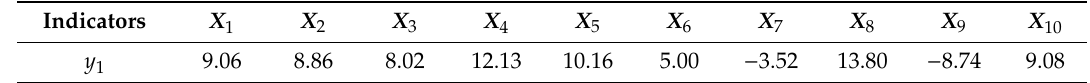
Table 4. Coe ffi cient of indicators of y 1 index.